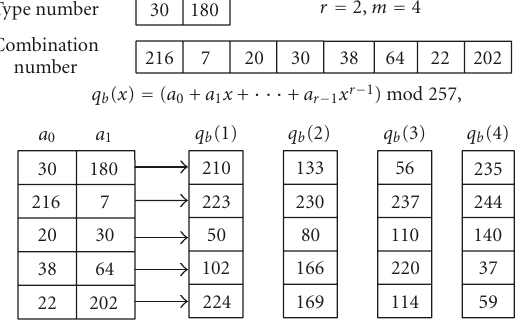
Figure 3: An illustration of the sharing phase.